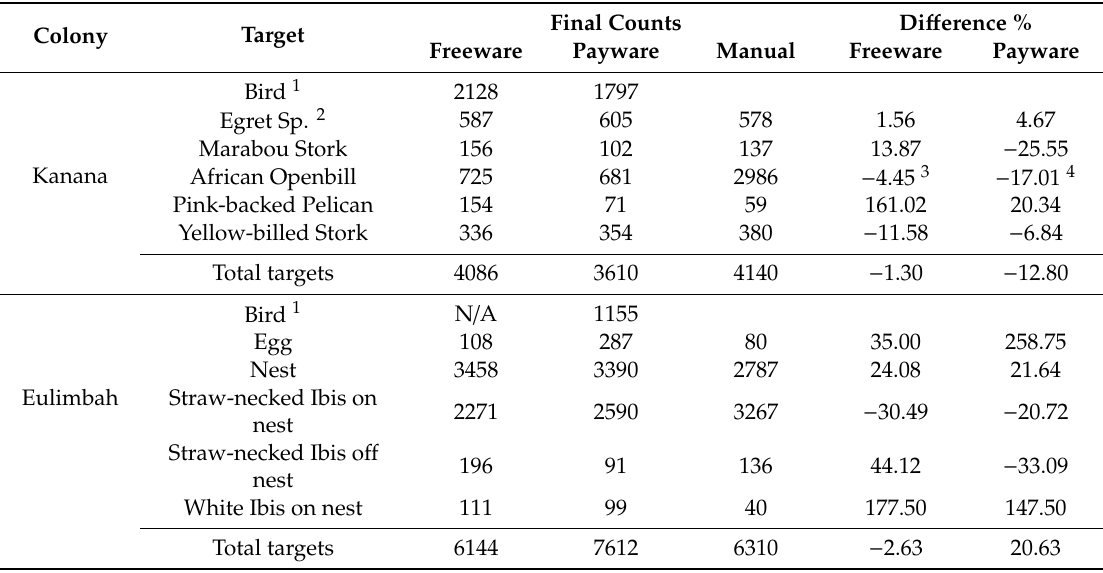
Table 2. Final target counts for both the Kanana and Eulimbah colonies with calculations of manual versus semi-automated